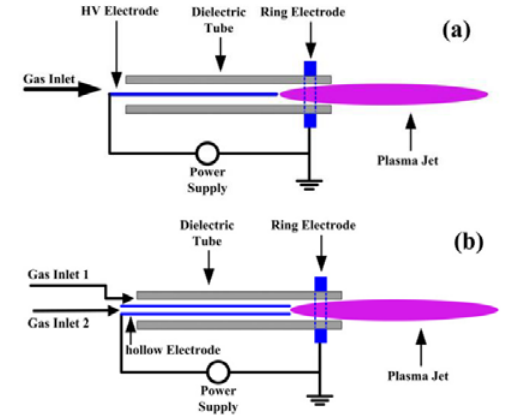
fig 3: Schematic of a DBD-like plasma